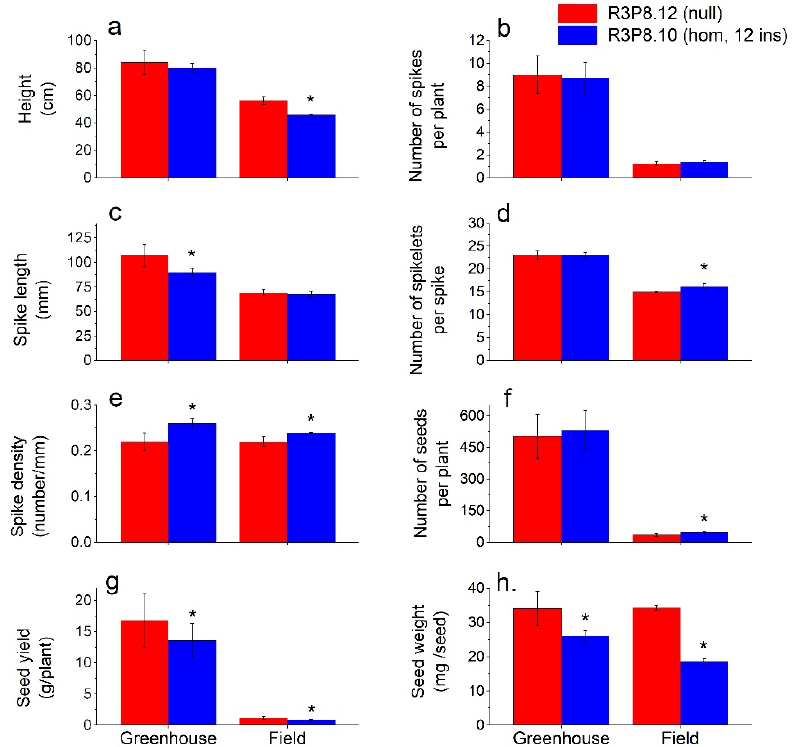
Figure 2. Comparison of plant and seed characteristics at grain maturity of greenhouse and field grown AsWRI1 -wheat (line R3P8.12, null (control); line R3P8.10, homozygous with 12 gene inserts). Height of plants in cm including spike ( a ), number of spikes per plant ( b ), length of spikes in mm ( c ), number of spikelets per spike ( d ), spike density as number of spikelets per mm ( e ), number of seeds per plant ( f ), seed yield as gram per plant ( g ), and seed weight as mg per seed ( h ). The results shown are mean values from triplicate plots in field (based on the averages from 10 plants per plot) and 20 plants grown in a greenhouse ± standard deviation. Bars marked with asterisks are significantly different to control (null) according to Tukey’s test at p < 0.05.